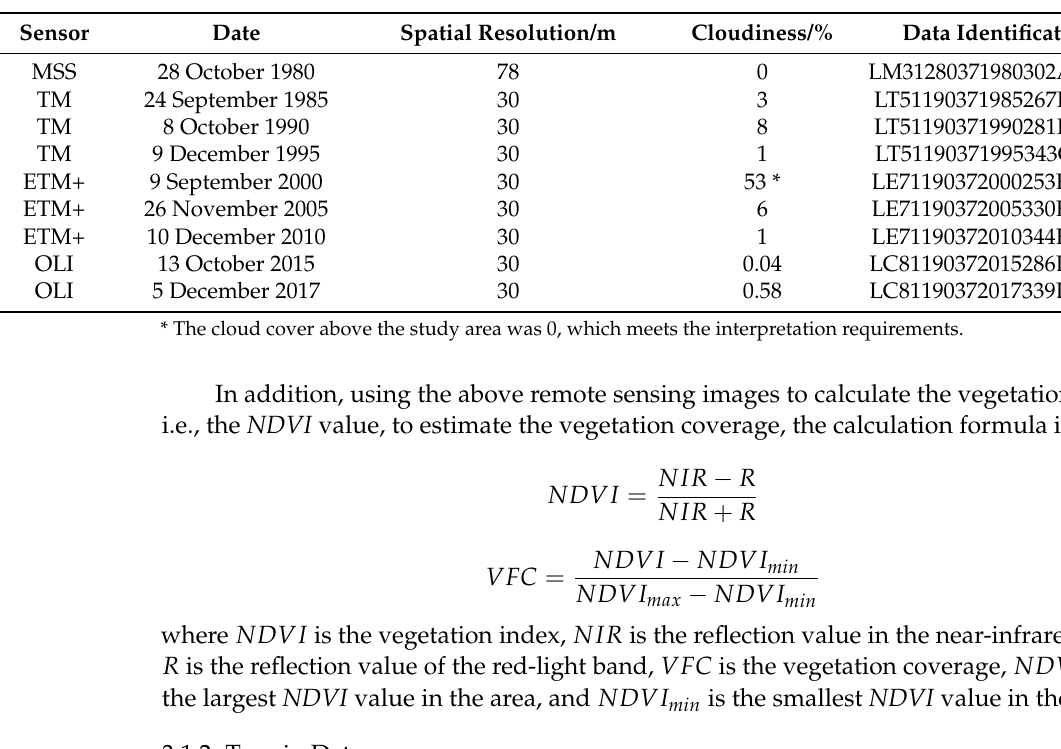
Table 1. Remote sensing image data source